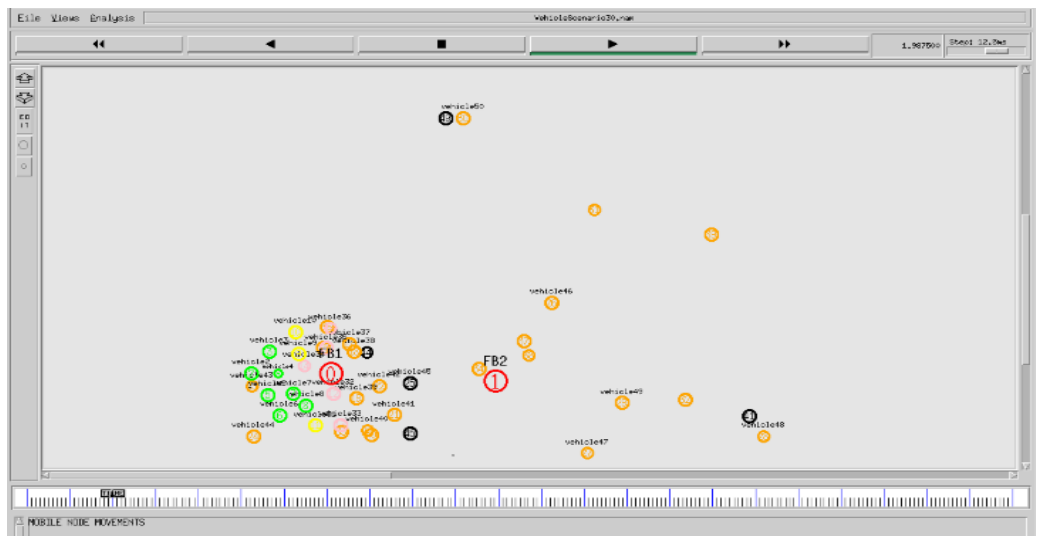
Figure 7. Tool command language (TCL) file for the proposed fog scenario.